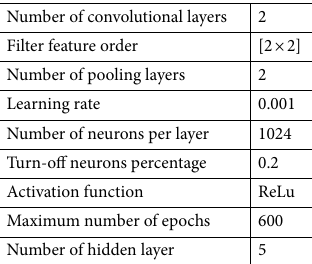
Table 1. Model hyperparameters.